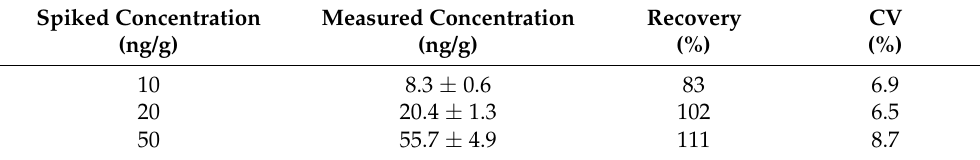
Table 6. Recoveries of carbofuran by the developed QD-LFIA. Spiked